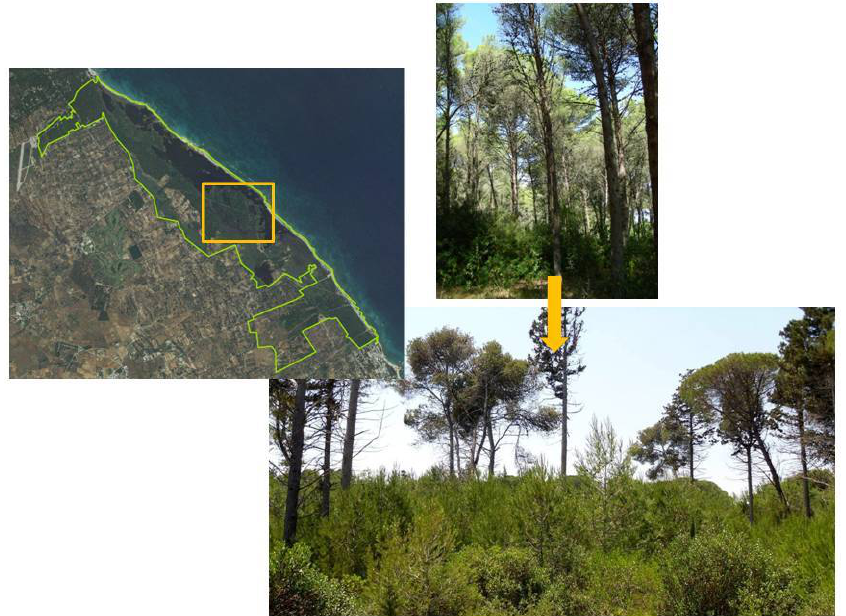
Figure 10. Localization of the area affected by canopy pine forest thinning in the CE site and photographic images depicting the ongoing process.